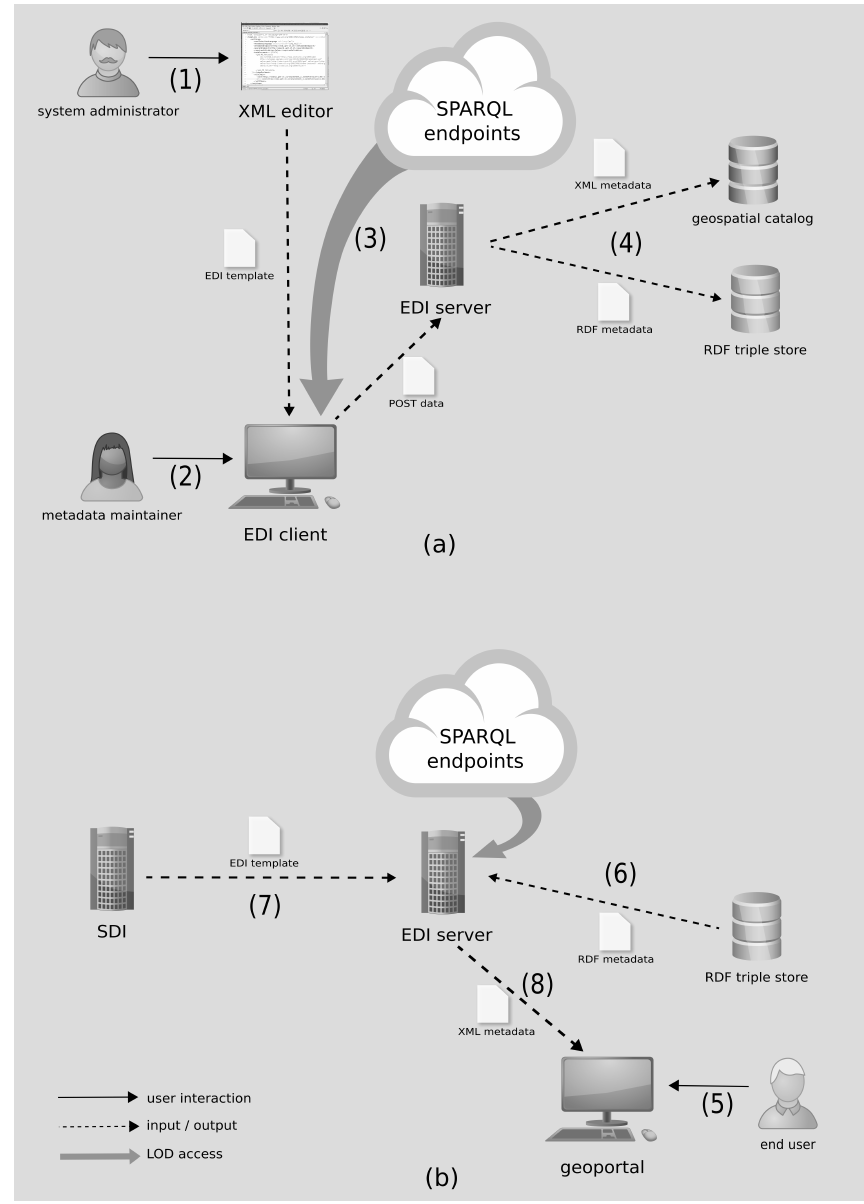
Figure 3. Workflow addressing: ( a ) production of the XML and RDF representations of the metadata record; and ( b ) on-demand generation of the XML